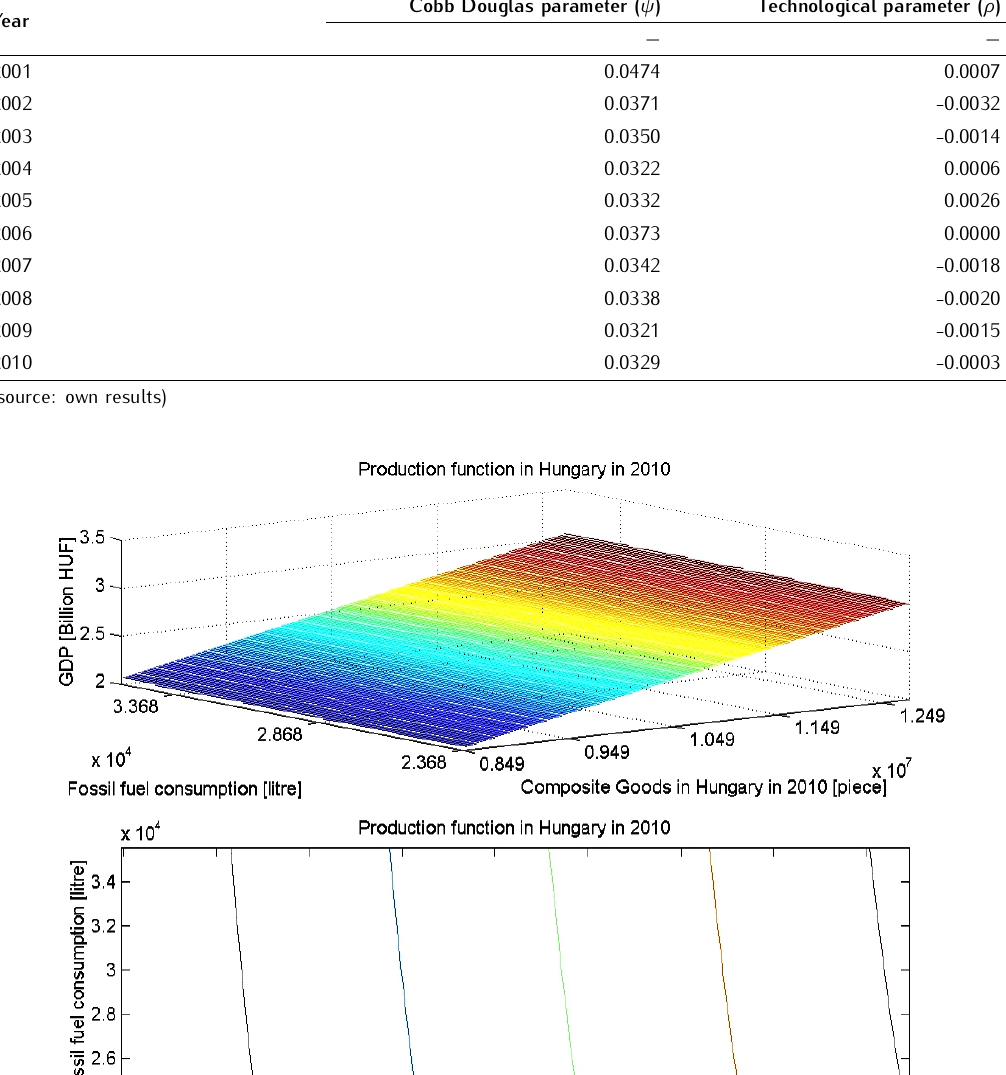
the only feasible, long-term solution is the technological development in case of lowering the emission without harming the